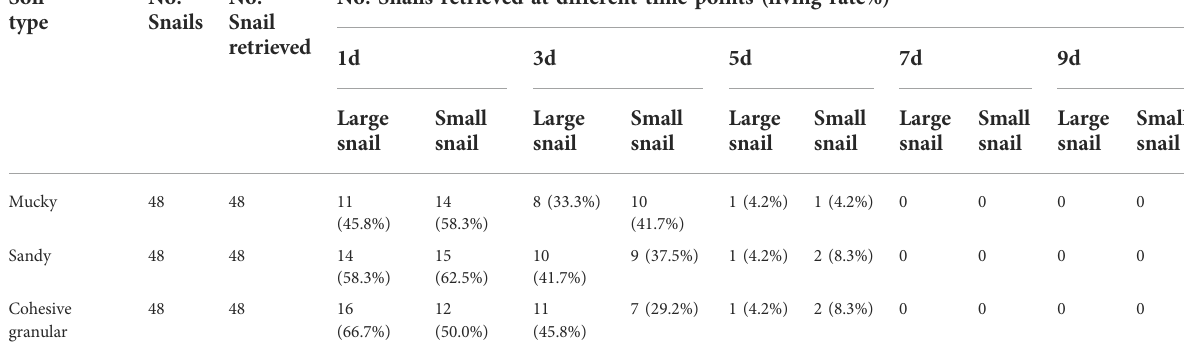
TABLE 2 The B. globosus parameters in Experiment 2 Soil type